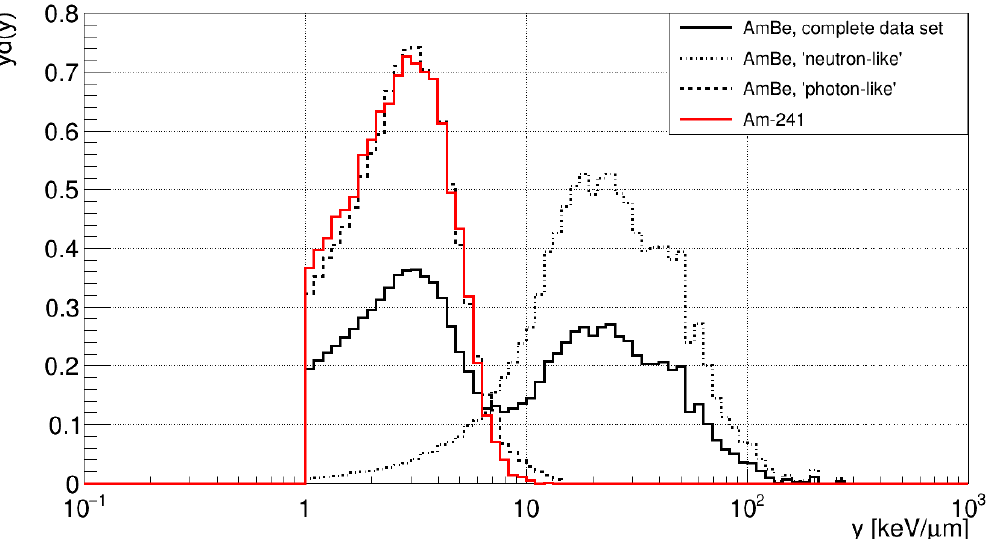
Figure 14. Dose spectra obtained with the GEMPix and an AmBe source (mixed photon/neutron field) in the standard representation for microdosimetry (lineal energy, y, on the x -axis and the dose distribution d(y) multiplied by y on the y -axis [51]). The complete data set (black line), the ‘neutron-like’ component (dash-dotted black line) and the ‘photon-like’ component (dotted black line) are shown. As a comparison, a measurement with the GEMPix and an 241 Am source (photons only) is presented (red line).